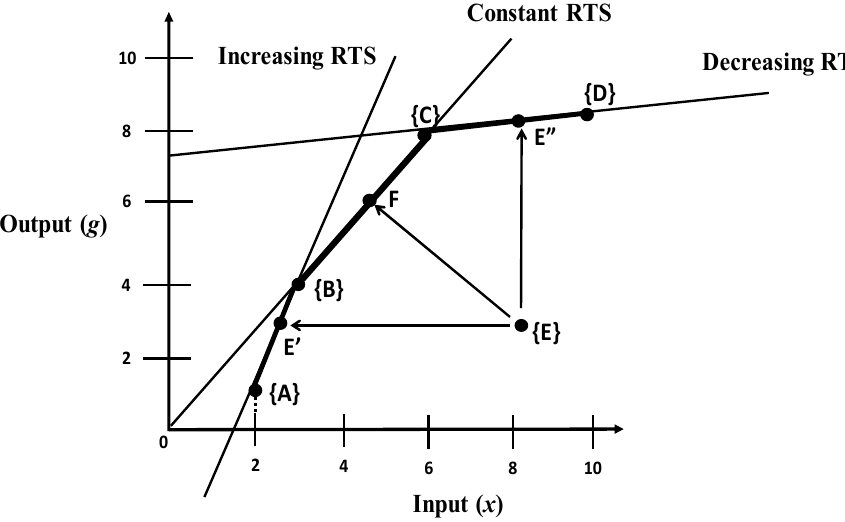
Figure 2. Projections from inefficiency to efficiency: Different types of RTS measures. Note: {E} is an observed DMU while E’, F and E” are the projected performances of DMU {E} on an efficiency frontier. This study uses { } to indicate the observed performance of a DMU.